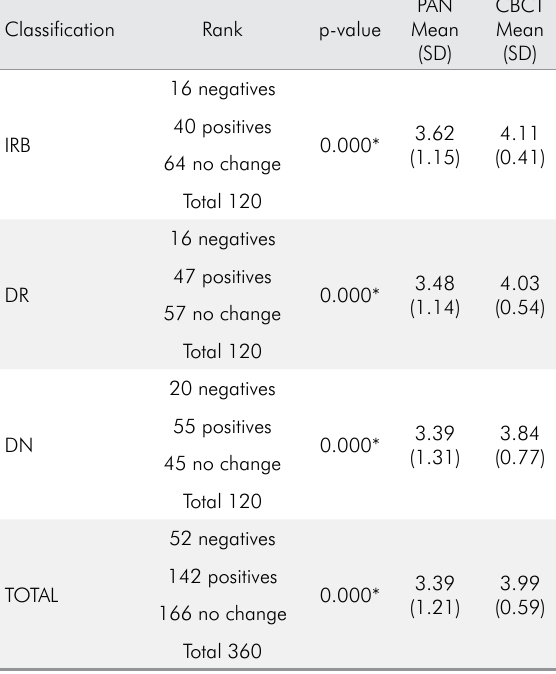
Table 3. Scores’ ranking for the question “At what level of difficulty would you classify the M3M extraction surgery?” A negative rank indicates greater difficulty when the panoramic exam was available, while a positive rank indicates greater difficulty after